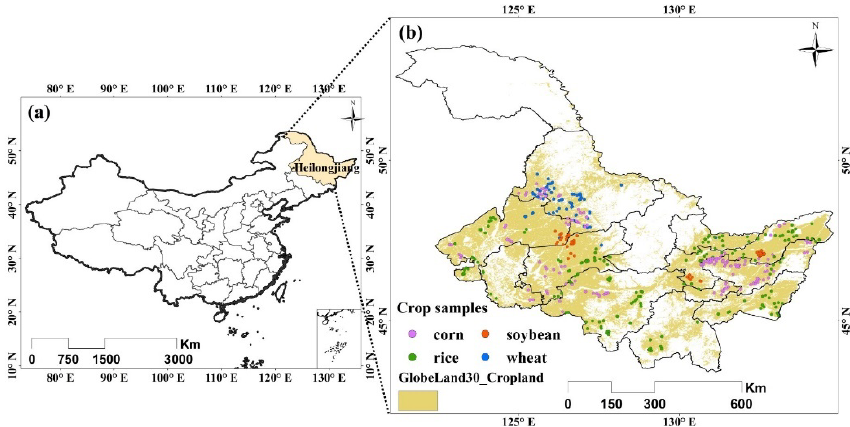
Figure 8. The study area location ( a ) and crop samples ( b ).